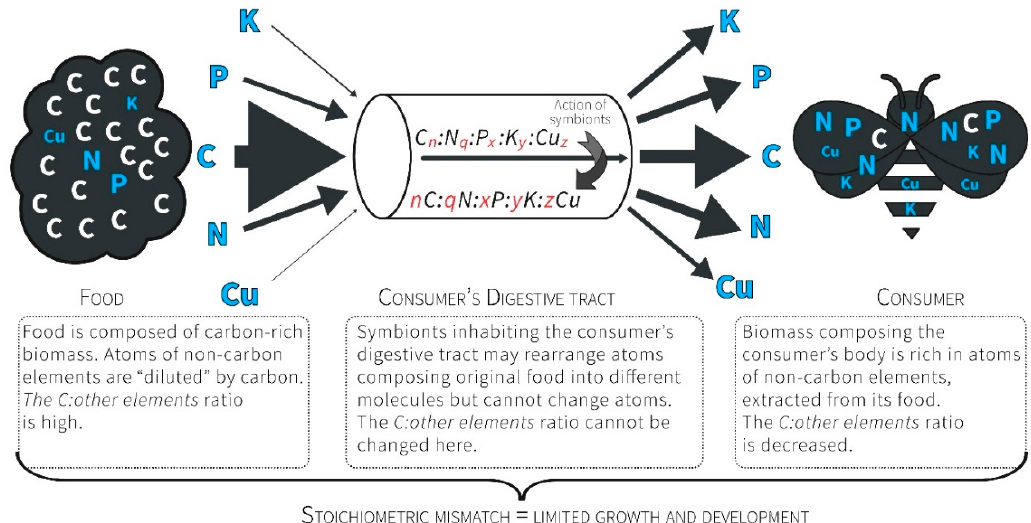
Figure 1. Consumers ingest a prepackaged ratio of atoms. For herbivores, the food contains more C relative to other atoms, so they must manage a diet that presents a stoichiometric mismatch through excess C, which is further exacerbated by the unbalanced relationships between non-C elements (due to the exceptional scarcity of some of them). Consumer graphic source: Vecteezy.com